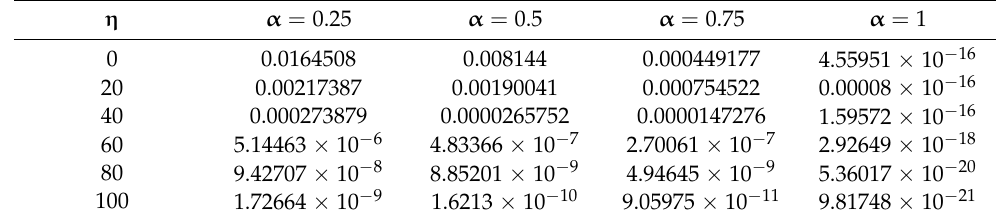
Table 8. AEf = | ( closed form solution ) − ( (cid:101) g ( η , t )) | .